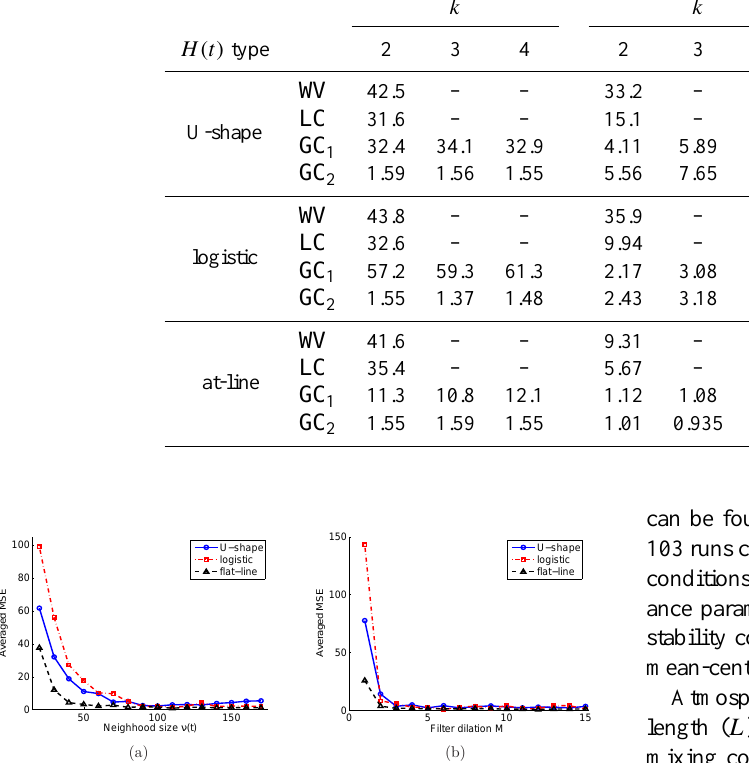
Figure 4: MSE averages for GC 1 depending on (a) different neighborhood sizes ν t Fig. 4. MSE averages for GC 1 depending on (a) different neighbor- and (b) filter dilation M are shown. hood sizes ν t and (b) filter dilation M are